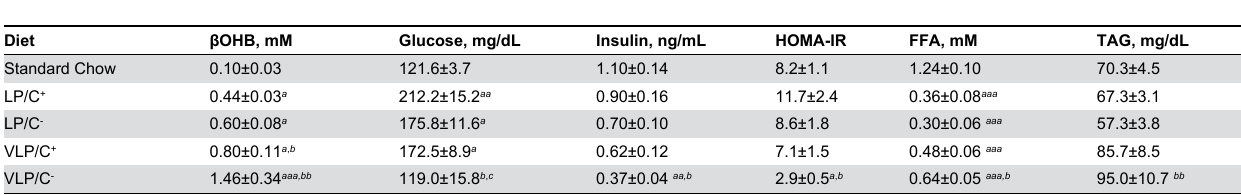
Table 2. Serum parameters after 6 weeks on